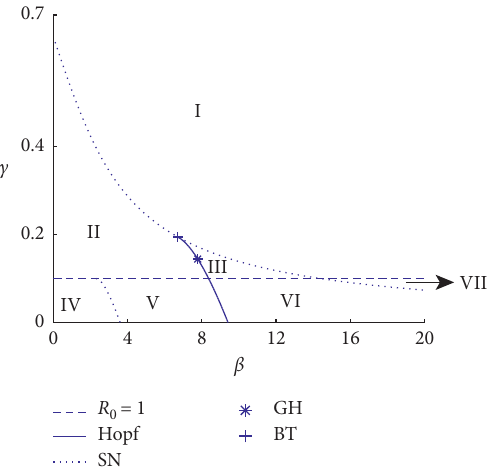
Figure 2: Bifurcation diagrams in the plane ( β , c ) . The parameter values are fixed as τ � 0 . 5 , n � 6 , ω � 2 .